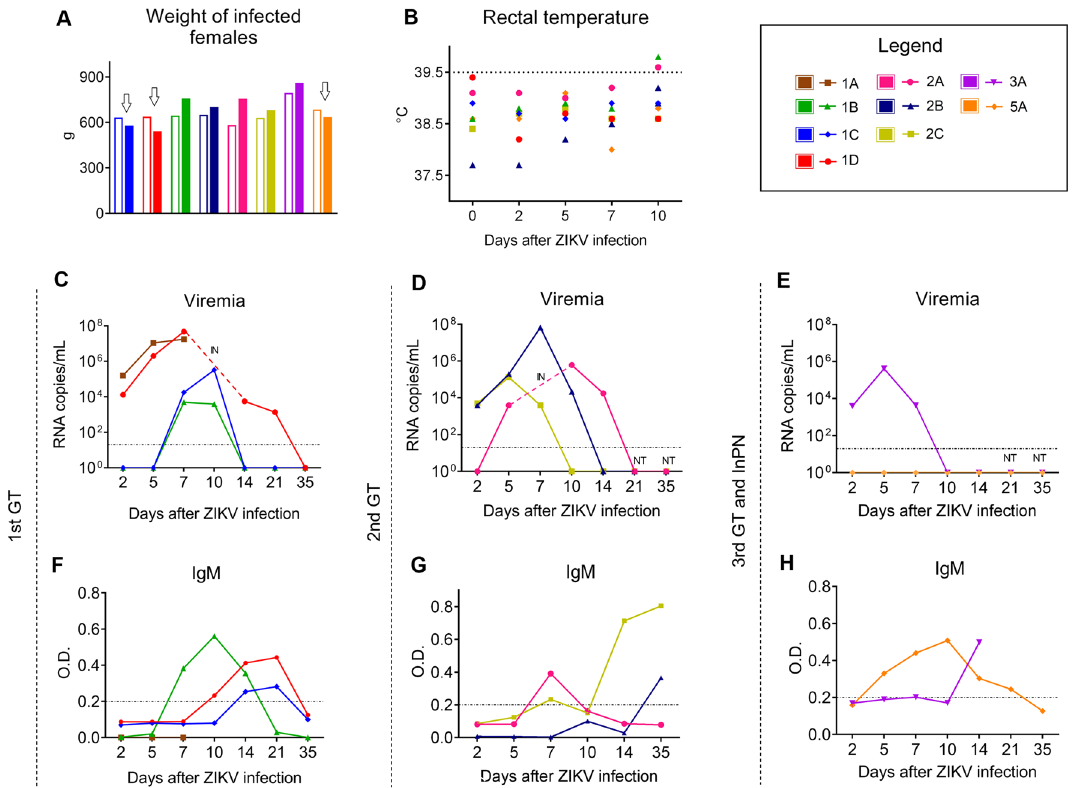
Figure 2. Experimental ZIKV infection in pregnant squirrel monkeys. Clinical ZIKV RNA load in blood and specific antibody profiles in the different infected animal groups. ( A ) Body weight of the females infected with ZIKV before (D0) (unfilled bar) and after infection (D35) (filled bar). Body weight reductions were registered (white arrows) in 1C, 1D and 5A. ( B ) Body temperature of infected pregnant females with ZIKV in the three- thirds of pregnancy and that of the infected nonpregnant monkey. The dotted line indicates rectal temperature (39.5 °C) to indicate the progression of the fever 61 . ( C – E ) Detection of viral RNA in blood in the 1st GT, 2nd GT, 3rd GT and InNP groups. (IN: Inconclusive and NT: Not tested). ( F – H ) Serologic results of anti-ZIKV IgM antibody detection by ELISA in animals in the 1st GT, 2nd GT, 3rd GT, and InNP groups. The dotted lines represent the limits of